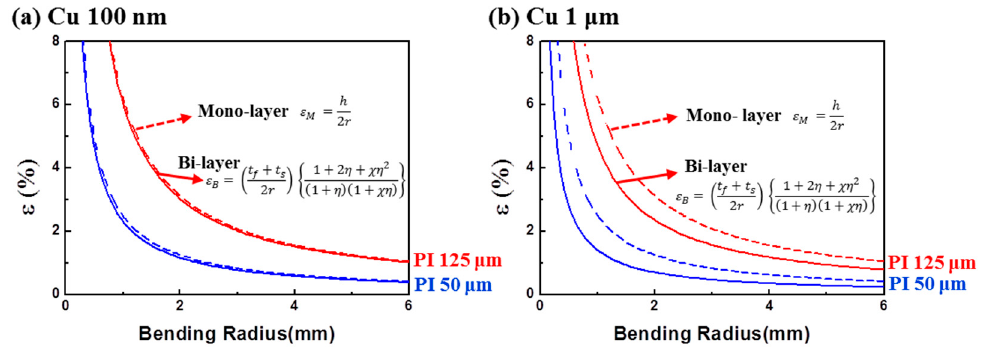
Figure 4. Calculated bending strains of ( a ) 100 nm thick Cu film and ( b ) 1 µm thick Cu film using monolayer and bilayer models.